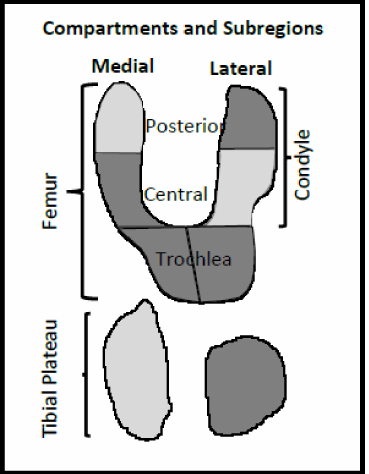
Figure 2. Representation of the knee bone curvature regions for the best prediction model for medial condyle cartilage volume loss at one year. The regions represented with the model M20-13-6 (dark) are lateral and medial trochlea, lateral posterior condyle, lateral tibial plateau, and medial central